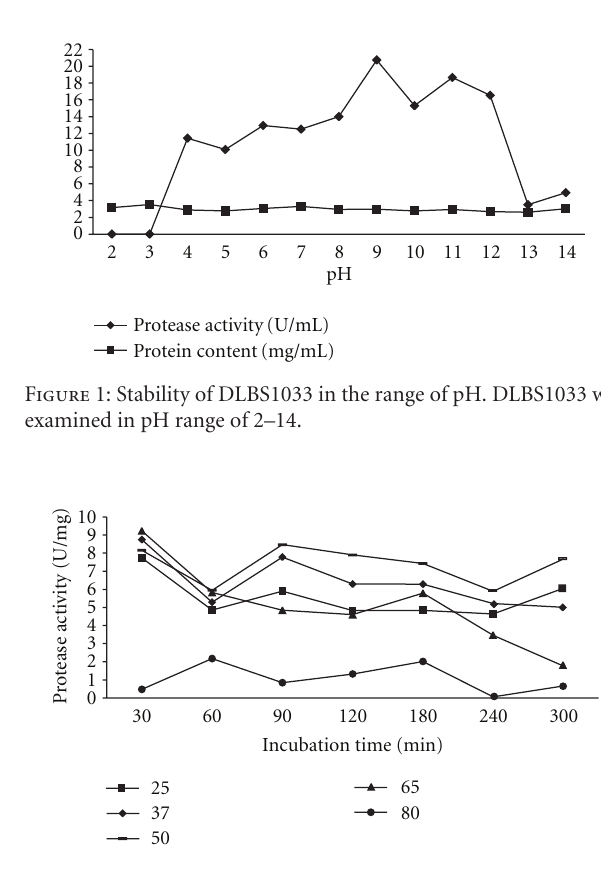
Figure 2: Stability of DLBS1033 in the range of temperature. DLBS1033 was examined in temperature range of 25 ◦ C–80 ◦ C for 5